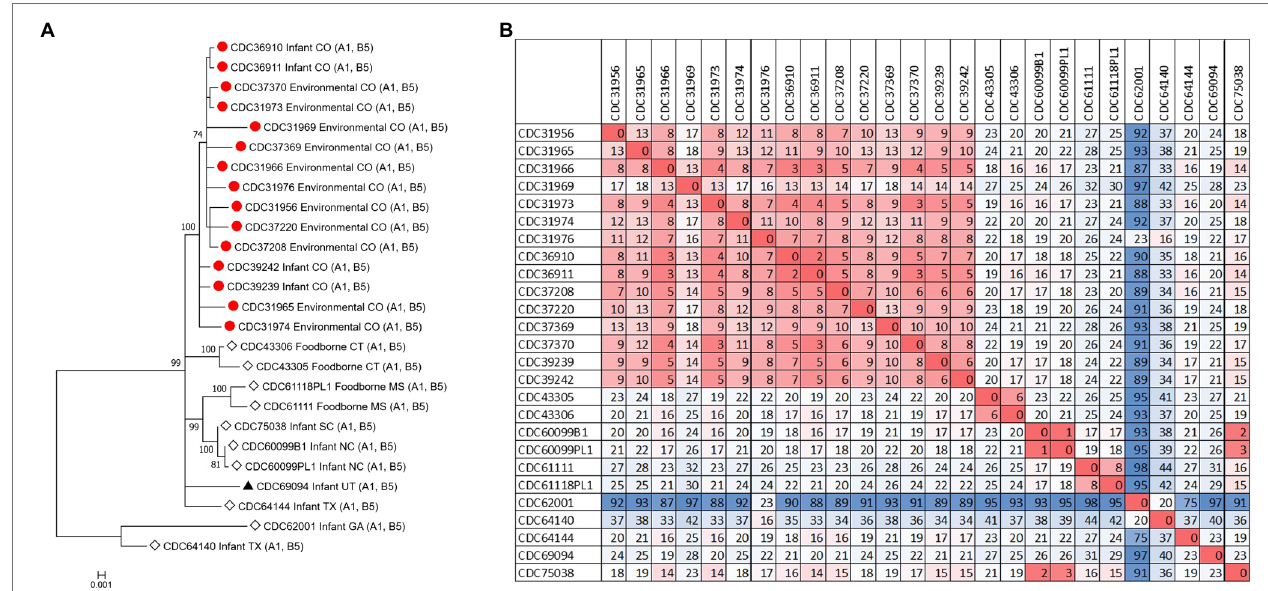
FIGURE 2 | (A) Maximum-likelihood whole genome high-quality SNP tree of C. botulinum type A(B) isolates harboring both bont /A1 and bont /B5 genes. Tree was drawn using Lyve-SET and includes study strains as described in Table 1 (red circles), reference sequences from NCBI (black triangles), and other unpublished sequences from C. botulinum type A(B) strains from the CDC reference collection (white diamonds). Scale bar represents the number of changes per 100 sites. Bootstrap values greater than 70 are shown. (B) Distance matrix of SNP counts from Lyve-SET. The matrix was drawn in Excel using conditional